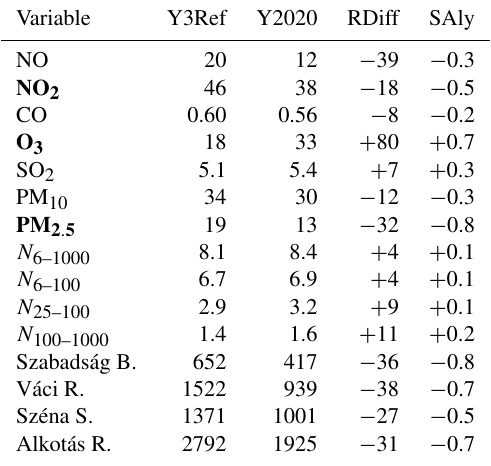
Table 3. Median atmospheric concentrations of NO, NO 2